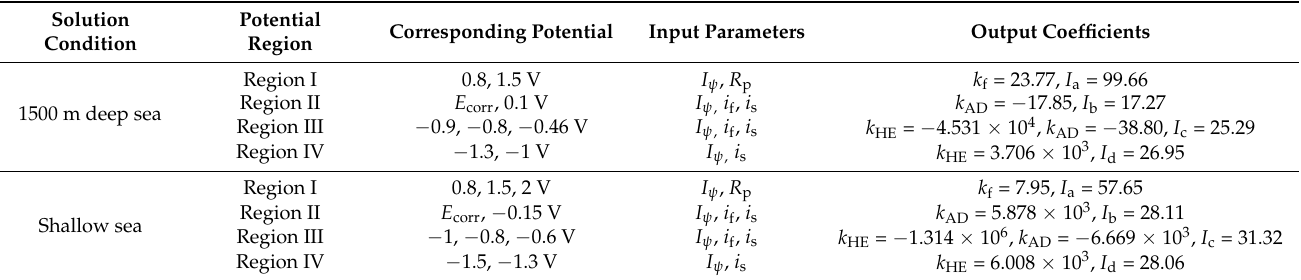
Table 3. The calculation method and results of coefficients of each potential region in simulated deep-sea and shallow-sea environments.